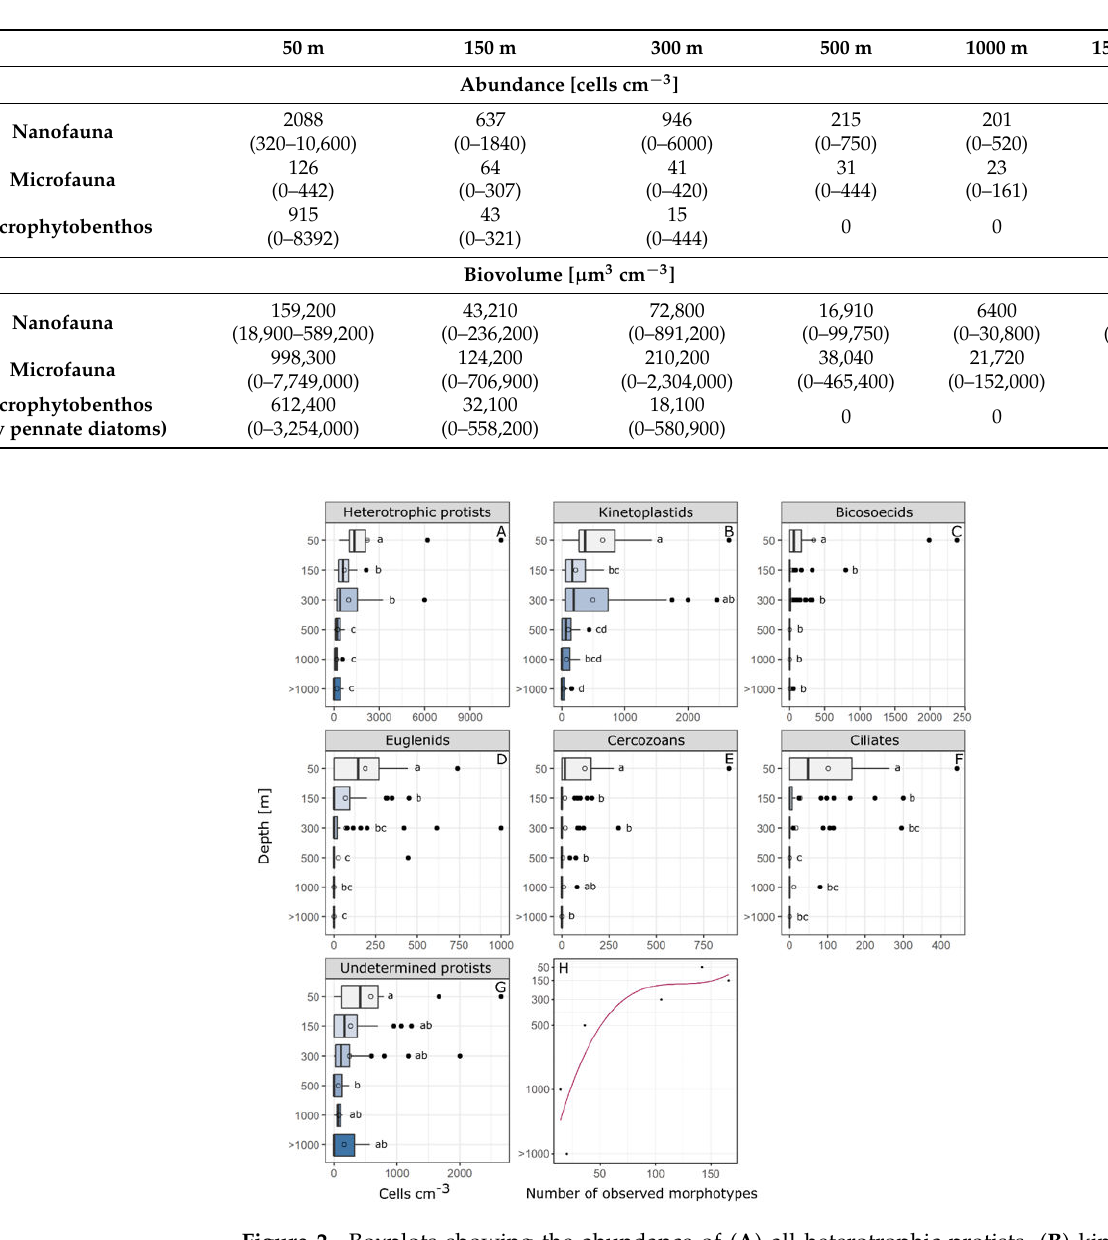
Figure 2. Boxplots showing the abundance of ( A ) all heterotrophic protists, ( B ) kinetoplastids, ( C ) bicosoecids, ( D ) euglenids, ( E ) cercozoans, ( F ) ciliates, and ( G ) undetermined protists in the different depths sampled (samples from 1500 to 3000 m were pooled). Empty circles indicate mean abundances per depth, filled circles show outliers, bold lines indicate the median. Letters next to the boxes indicate the results of the Kruskal–Wallis test with Dunn’s test for multiple compar- isons as the post-hoc test. Different letters indicate significant differences between abundances ( p < 0.05). ( H ) Correlation between depth and the number of observed morphotypes (Spearman’s rank correlation coefficient rho = − 0.89, p <